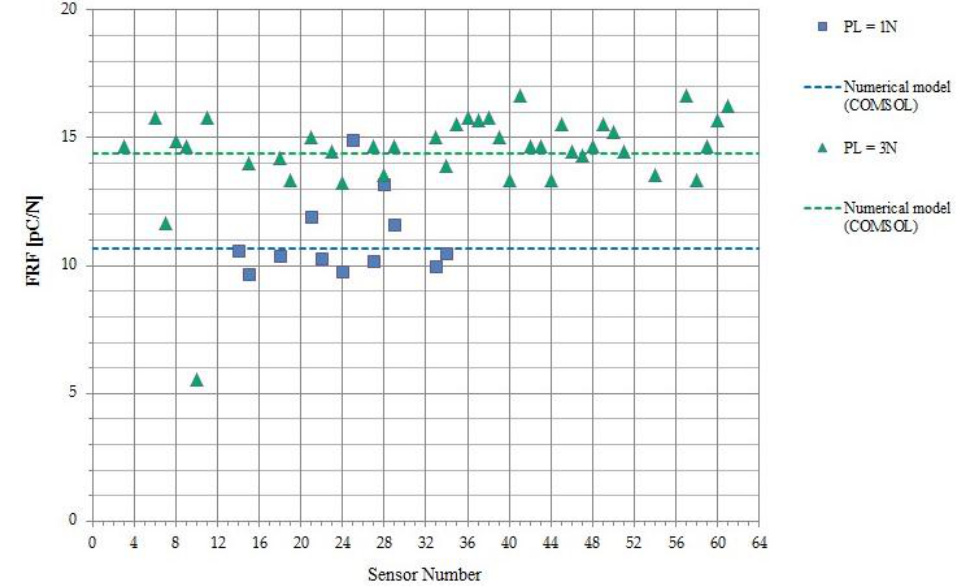
Figure 16. Model validation. The dynamic force amplitude is 0.09 [N] in both cases. Dotted lines correspond to the values of the response function predicted by the numerical model, for the two different preloads.